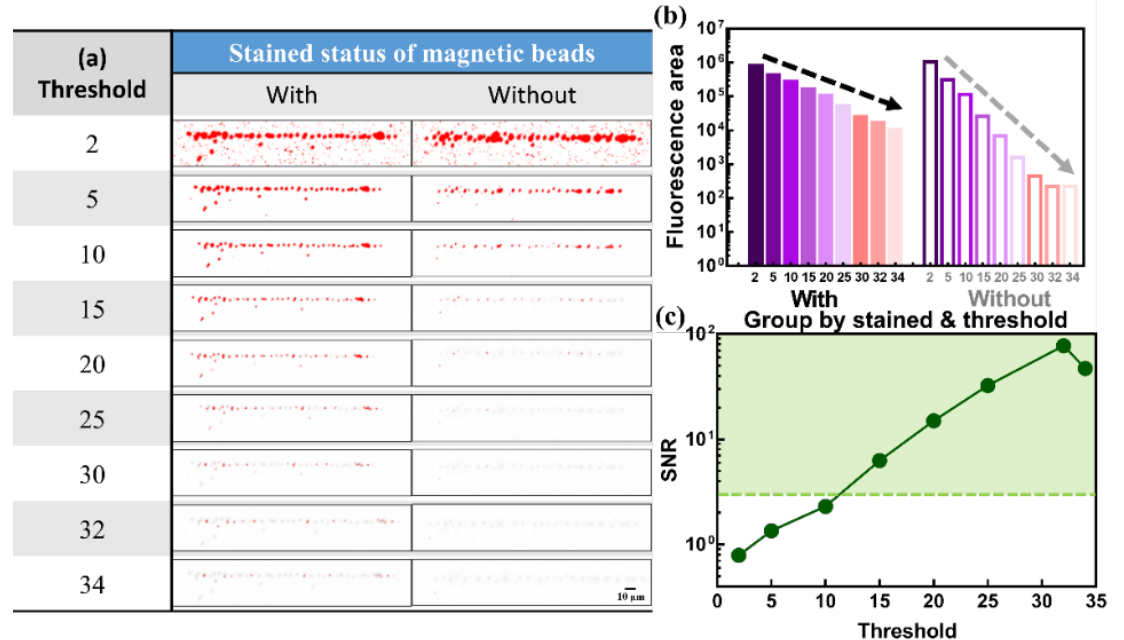
Figure 8. ( a ) Images and ( b ) bar chart of the relative fluorescence area and ( c ) SNR calculated by ImageJ with a detection threshold of 2, 5, 10, 15, 20, 25, 30, 32, and 34 magnetic beads with a diameter of 4.2 µ m with and without staining. It can be clearly seen that the detection threshold value of 32 is a good index to distinguish magnetic beads with and without staining.